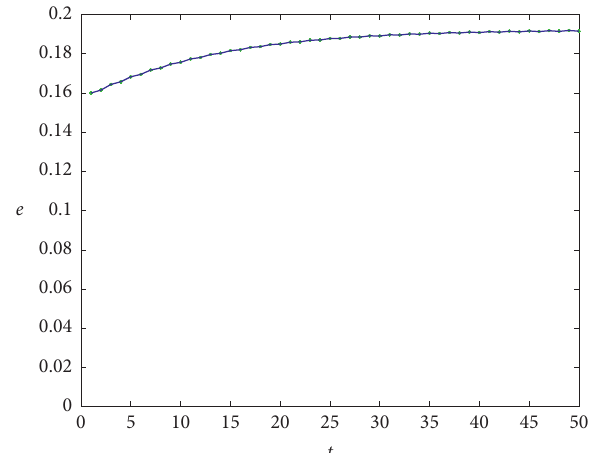
Figure 15: The eco-innovative effort fluctuations of the